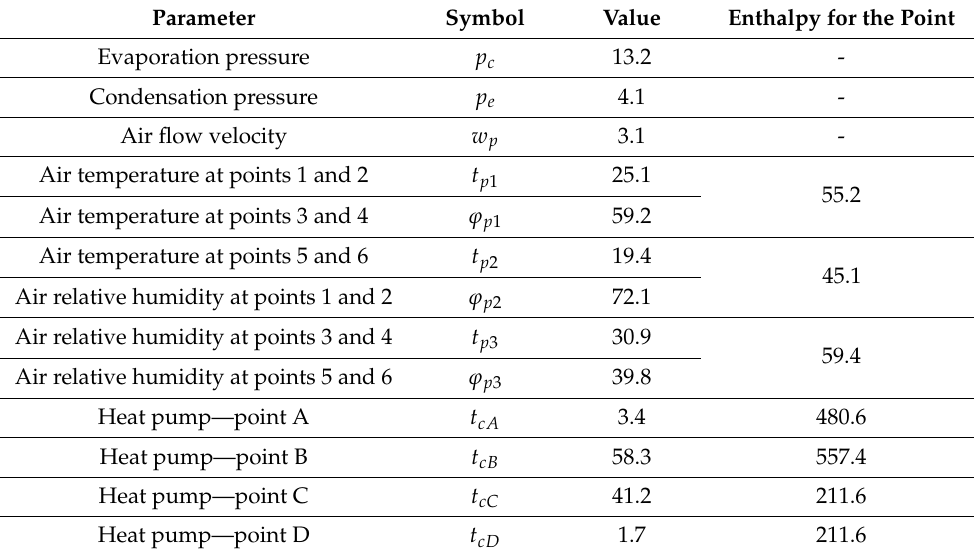
Table 7. Averaged measurement values.